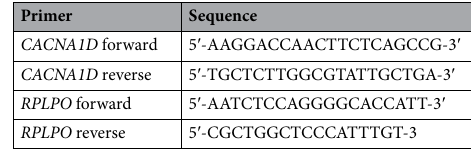
Table 1. qPCR primers and sequences.